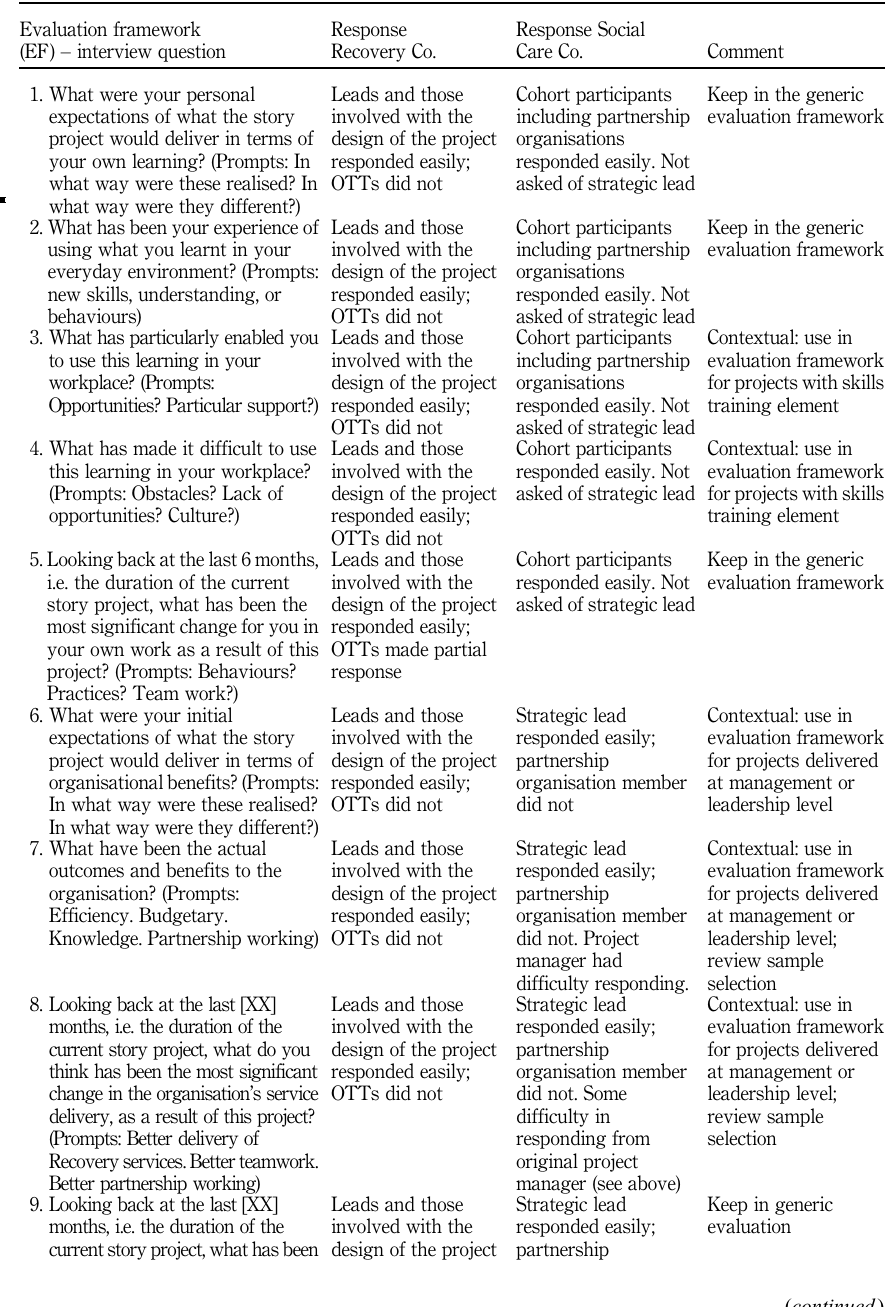
Table III. Reflections on implementing the evaluative framework